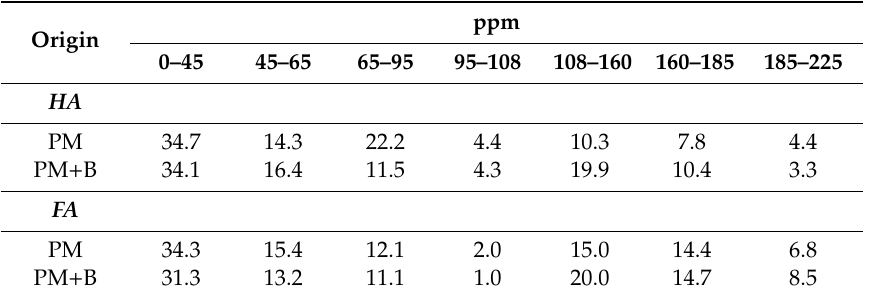
Table 3. Relative abundances of di ff erent carbon (in %), measured by 13 C CPMAS NMR of humic acid-like (HA) and fulvic acid-like (FA) in maturation phase extracted from poultry manure compost (PM) and poultry manure blended with biochar (PM + B).